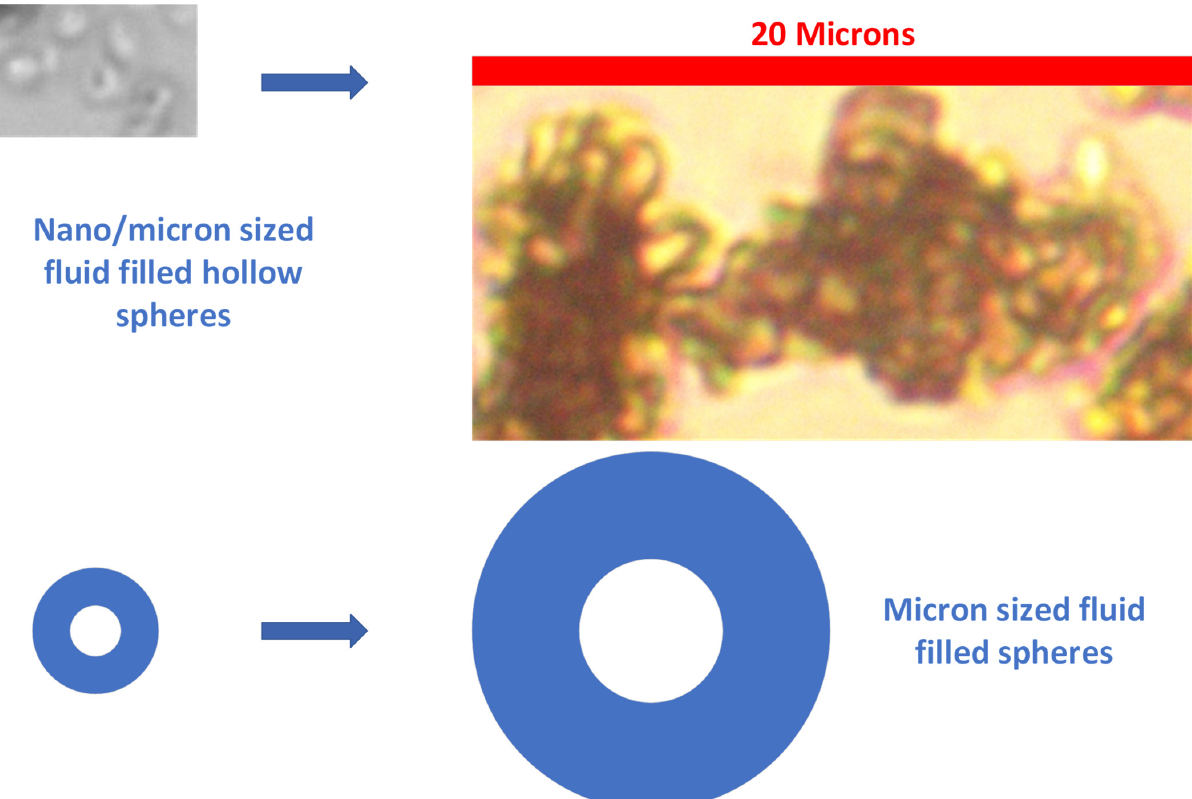
Figure 5. n-Fe 0 (50 nm) in saline water, illustrating the initial entrained n-Fe 0 :Fe(a,b,c) sphere formation (within 1 h), and their subsequent growth and mineralization encasing the ions removed from the water body. Field of view of the grey insert photograph is 5.7